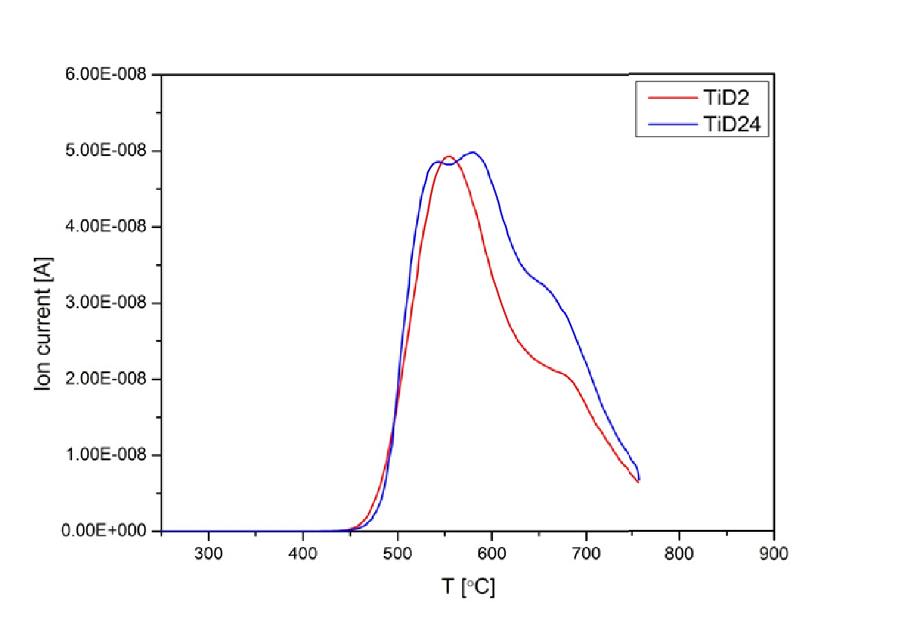
Fig. 2. Mass 4 a.m.u. ion current as a function of titanium sample temperature for two different titanium samples marked as TiD2 and TiD24. The only difference between the two samples is different previous radiation